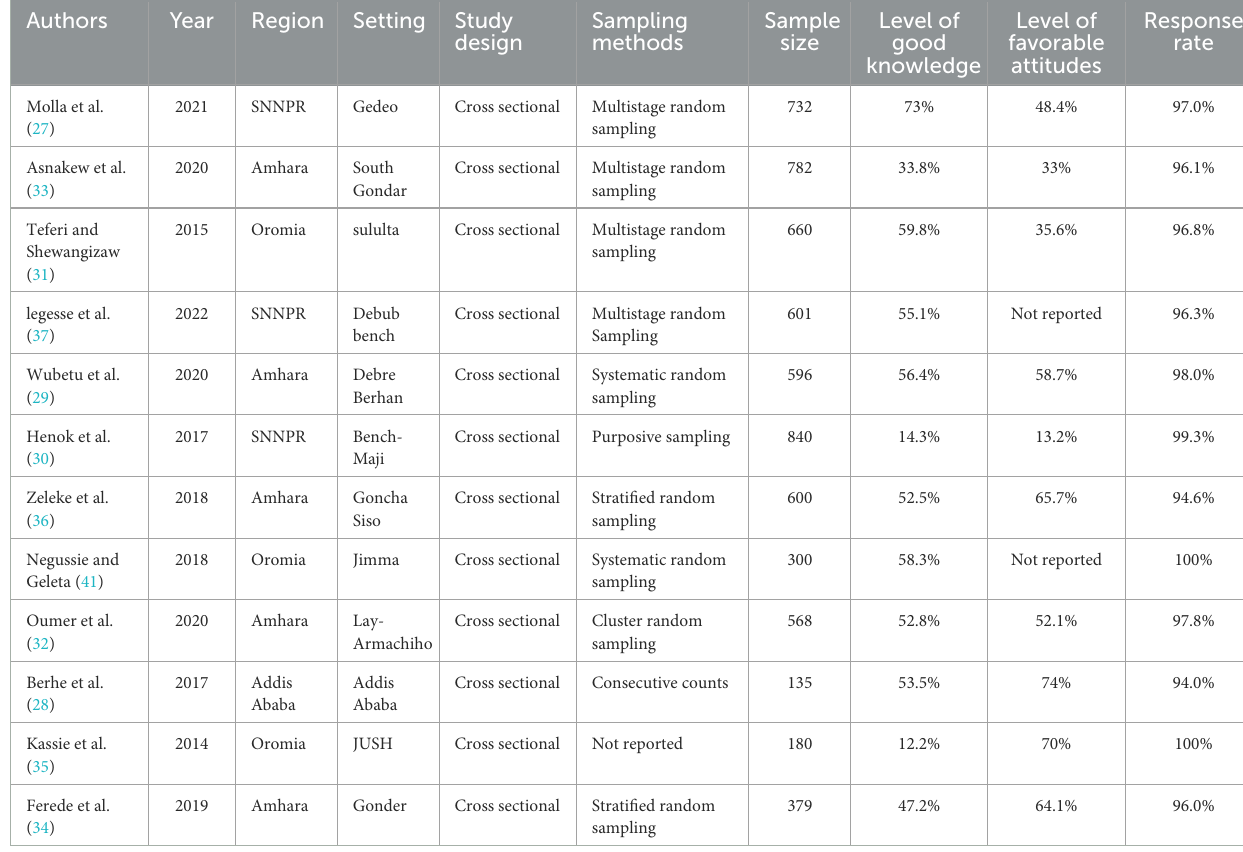
TABLE 1 The characteristics of the studies included in the systematic review and meta-analysis. Authors